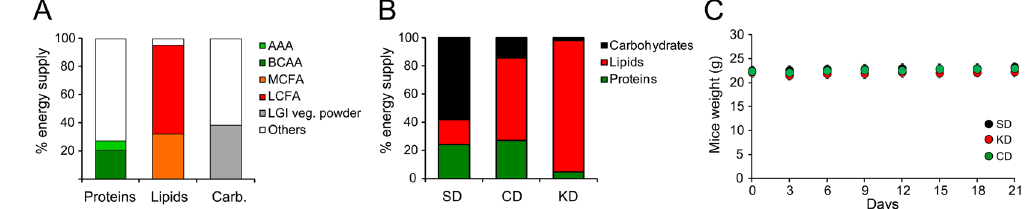
Figure 1. Novel diet combining nutritional strategies reducing the ratio of [fat]:[proteins + carbohydrates]. ( A ) combined diet composition of the total caloric supply. ( B ) proportion of macronutrients caloric supply for SD, CD, and KD. ( C ) monitoring mice weight every third day upon 3 weeks of dietary treatment revealed no change in body